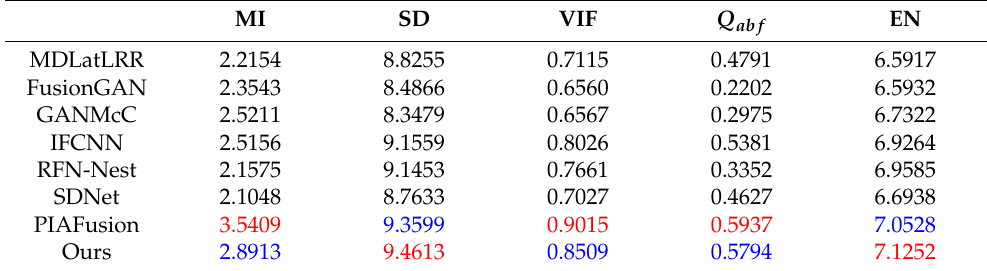
Figure 9. Generalization experiment for different fusion network of a typical sample from the TNO dataset. Table 5. The results of different metrics for the eight algorithms on the 20 TNO dataset. The red value indicates the best result and the blue value indicates the second best